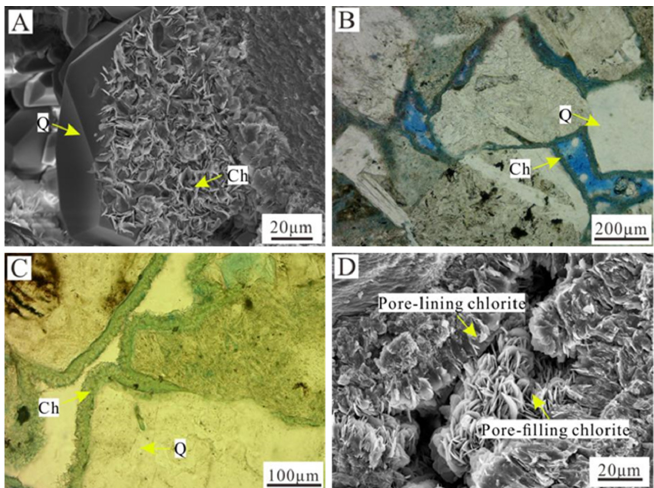
Figure 3. Occurrence of authigenic chlorite in Longfengshan subsag. ( A ) Chlorite coating, well Bei 202, 3087.48 m, SEM. ( B ) Pore-lining chlorite, well Bei 202, 3117.8 m, plane-polarized light. ( C ) Pore- lining chlorite, well Bei 210, 3949.75 m, plane-polarized light. ( D ) Pore-lining chlorite and pore-filling chlorite, well Bei 202, 3113.28 m, SEM. Ch—Chlorite; Q—Quartz.